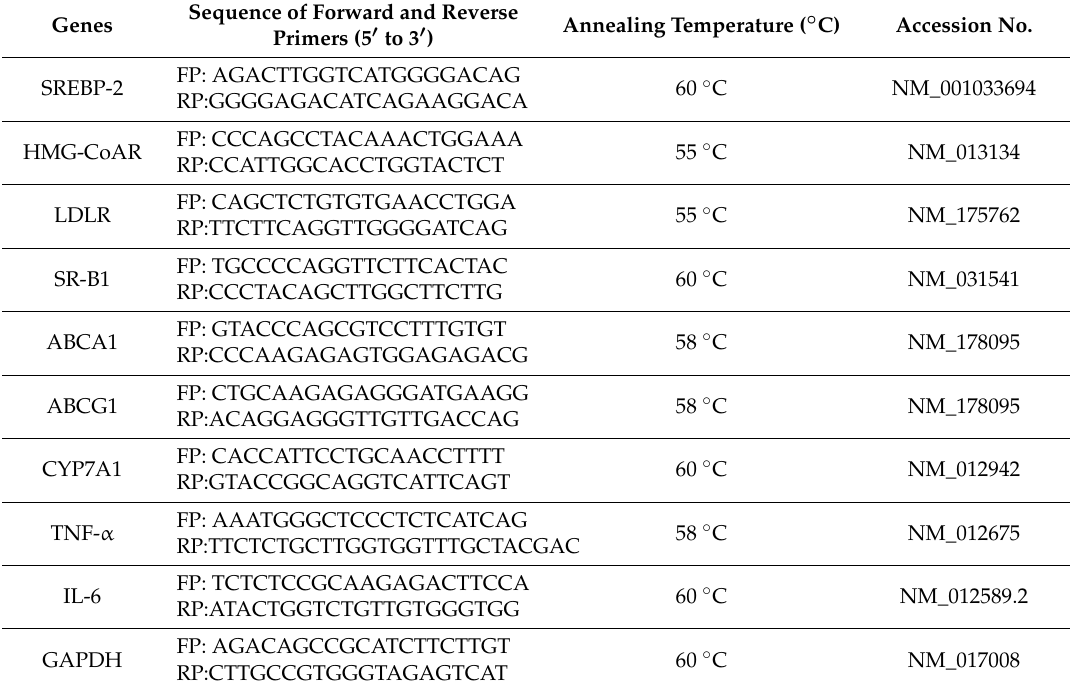
Table 1. Primers used for Quantitative Reverse Transcription Polymerase Chain Reaction (RT-qPCR).